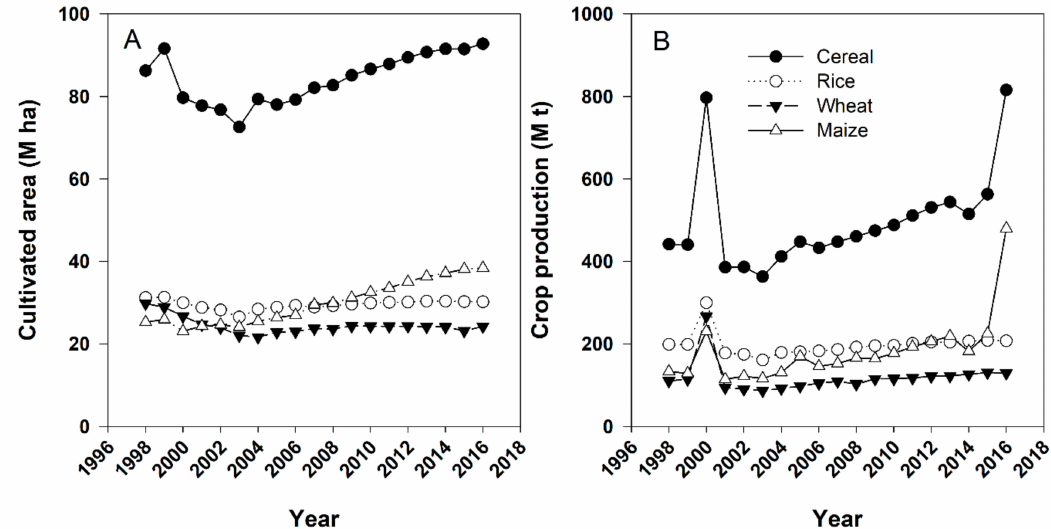
Figure 4. The cereal, rice, wheat, and maize cultivated area ( A ) and production ( B ) in China from 1998 to